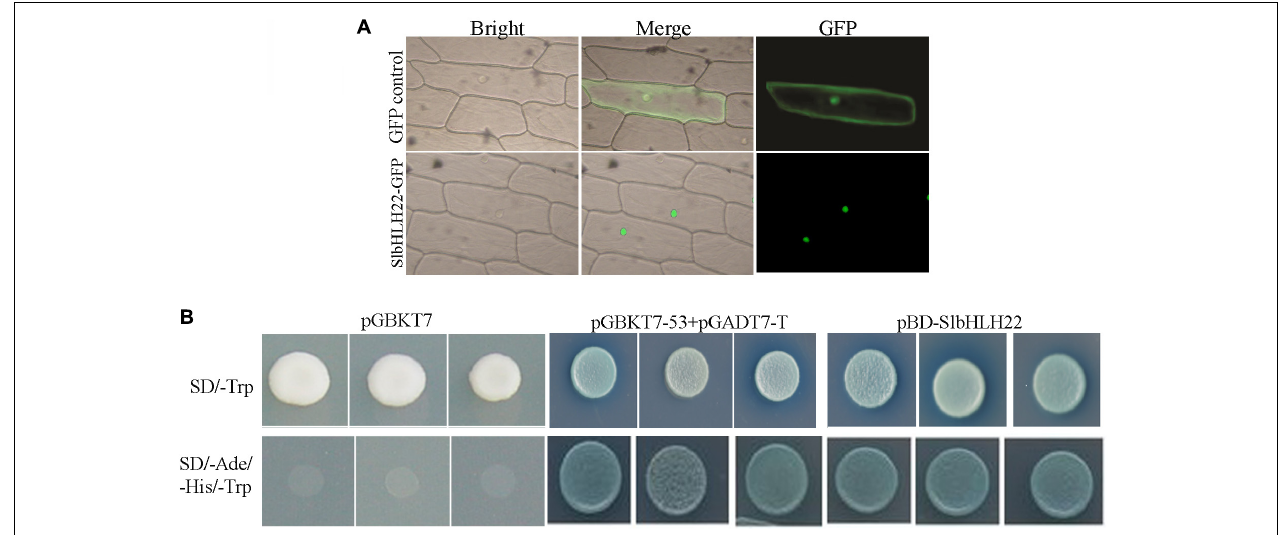
FIGURE 2 | Subcellular localization and transcription activity of SlbHLH22 . (A) The images were taken under bright light, merged, and in the dark field for the GFP-derived green fluorescence, respectively. (B) Analysis of the transactivation activity of SlbHLH22 . Up, SD/-Trp-drop medium, below, SD/-Ade/-His/-Trp-drop medium both supplemented with X-gal for assaying yeast reporter (MEL1) gene.